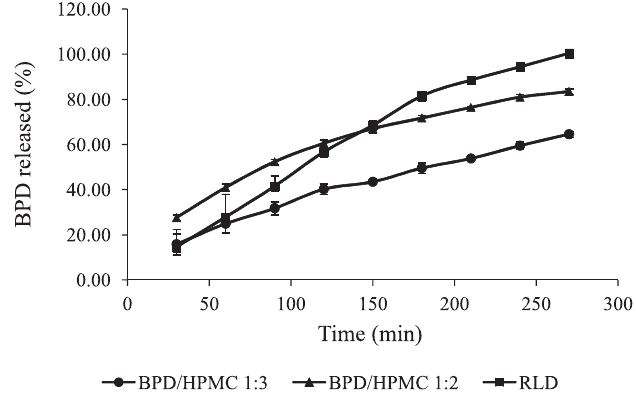
FIGURE 1 - Dissolution profiles of bromopride tablets: BPD/ HPMC 1:3; BDP/HPMC 1:2; Reference Label Drug in 0.1 M HCl dissolution